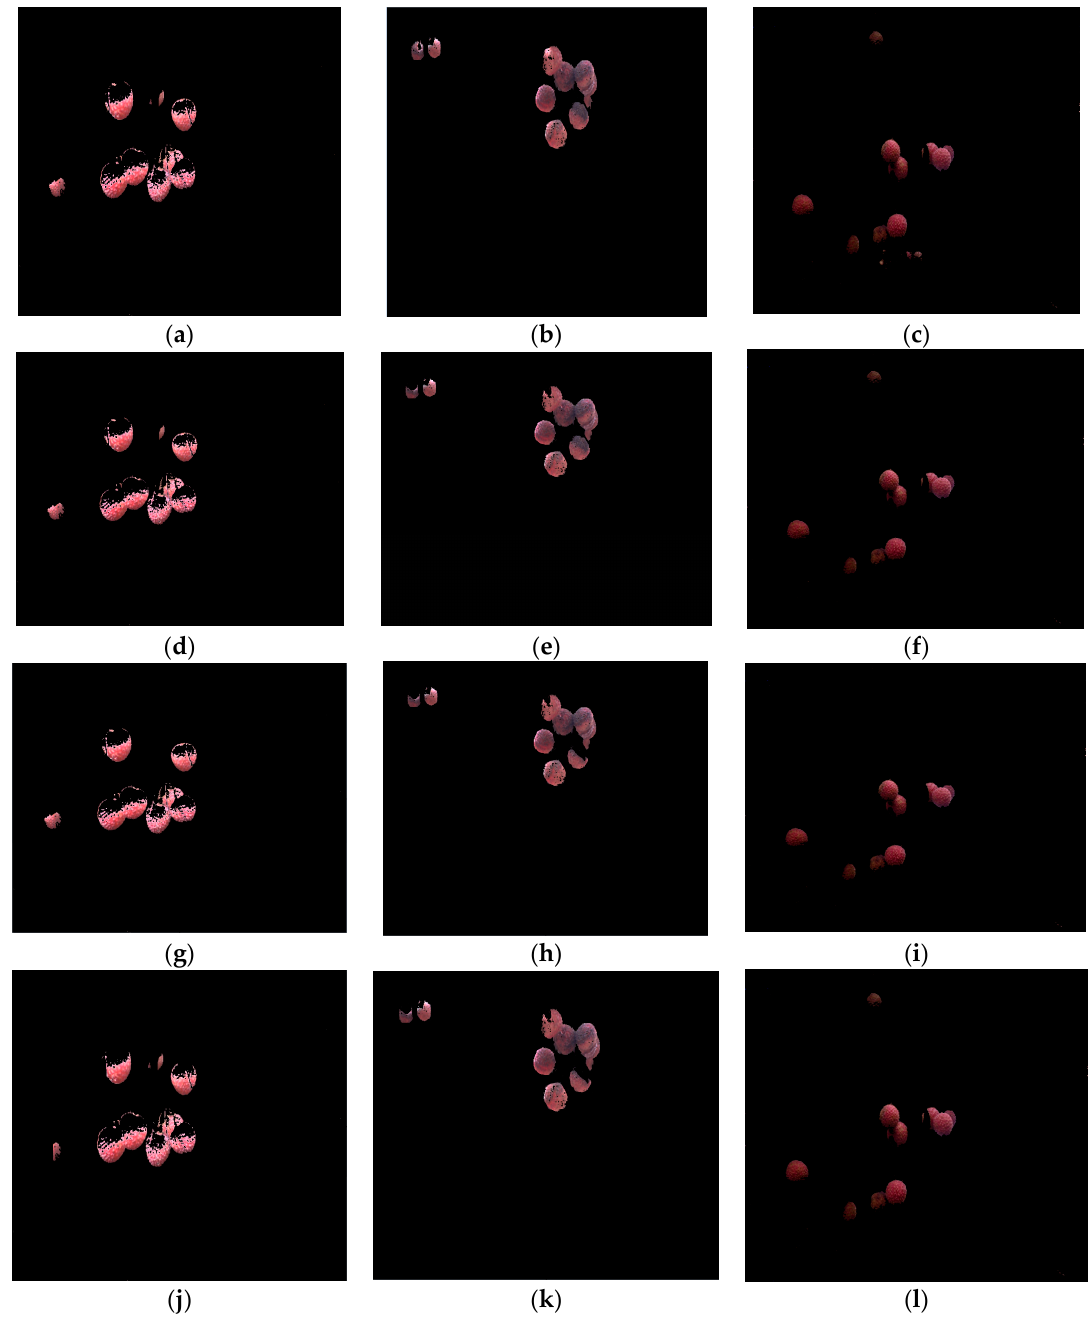
Figure 12. Litchi fruit extraction result by using different classifiers under different illumination conditions. ( a – c ) Litchi fruit extraction result by using the naive Bayes classifier under different illumination conditions; ( d – f ) Litchi fruit extraction result by using the KNN classifier under different illumination conditions; ( g – i ) Litchi fruit extraction result by using the BP neural network classifier under different illumination conditions; ( j – l ) Litchi fruit extraction result by using the SVM classifier under different illumination conditions.